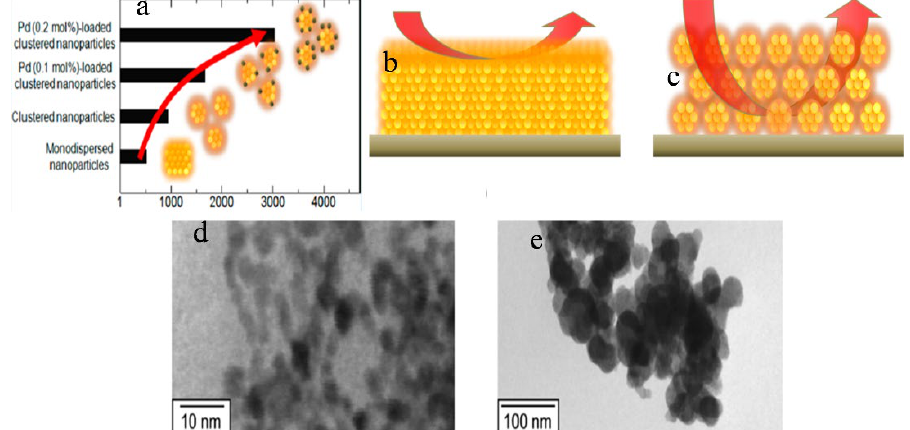
Figure 5. ( a ) Sensor response of different nanoparticles to toluene; ( b , c ) represent the gas diffusion in films made with monodispersed nanoparticles and clustered nanoparticles, respectively; ( d ) and ( e ) are the TEM images of SnO 2 nanoparticles at pH 10.6 and pH 9.3, respectively. (Reprinted with permission from [71]. Copyright 2014, American Chemical Society, Washington, DC, USA).